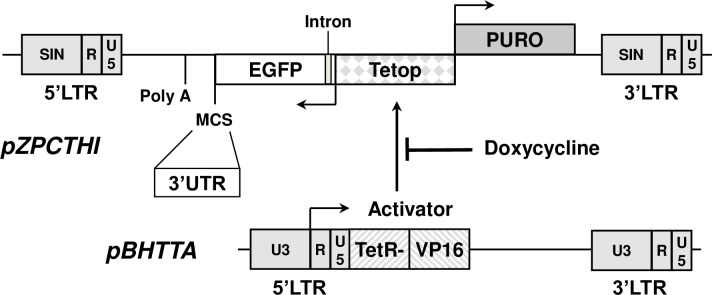
Tet-off vector-system used for RNA-decay measurements.A newly constructed retroviral vector pZPCTHI (for details see S1 Methods) comprises a 7x tet-operator [43] located between a CMV minimal promoter [43] to express the puromycin-resistance gene and a heterologous minimal promoter [44] to transcribe EGFP reporter constructs. Multiple cloning sites (MCS) for EcoRI, BglII and NotI immediately downstream of the GFP coding sequence serve to insert various 3'UTRs. A chimeric intron [52] was inserted into the EGFP 5’UTR. The polyadenylation signal is from the bovine growth hormone gene of vector pcDNA3 (Invitrogen). A second vector, pBHTTA, which encodes the tetracycline-sensitive transactivator protein (tTA) [43] was stably expressed in NIH/3T3 cells to generate a NIH/3T3-BHTTA cell line. All ZPCTHI constructs were subsequently tested in this cell line.